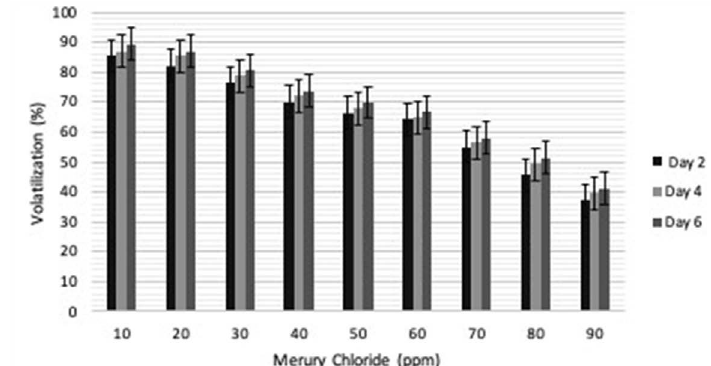
by P02 in nutrient media (LB+HgCl 2